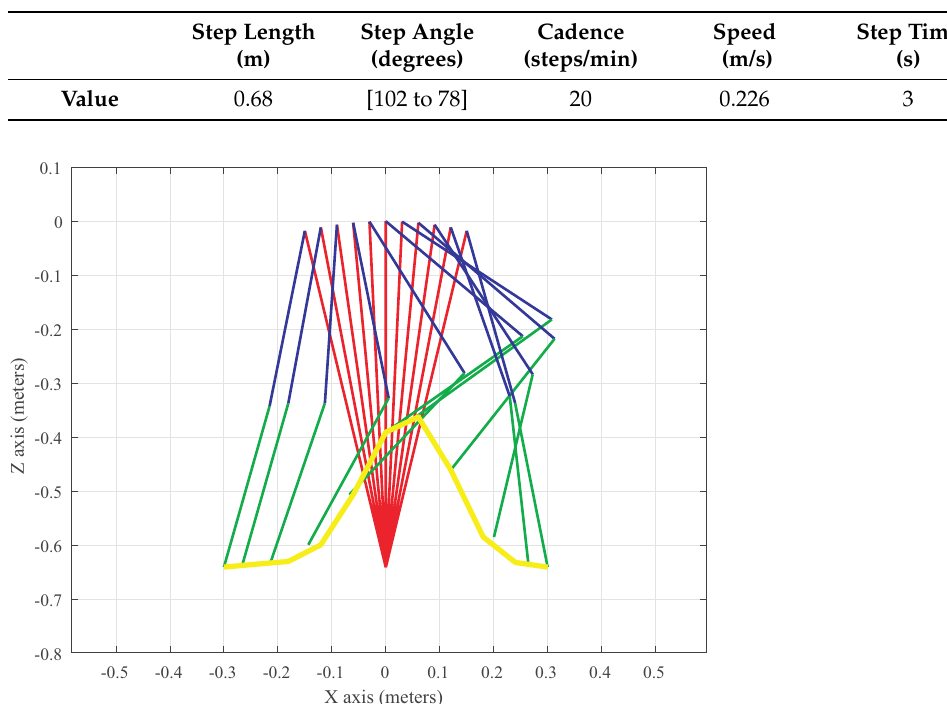
Table 3. Gait trajectory parameters [44] .